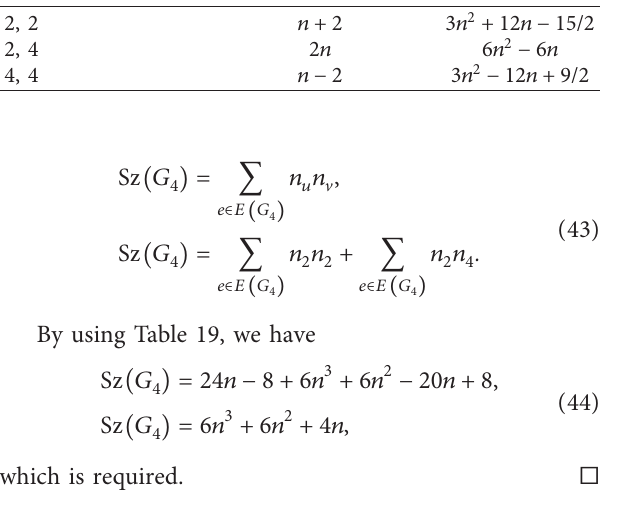
Table 18: Edge partition of ortho chain of odd order. Edge partition d u , d v